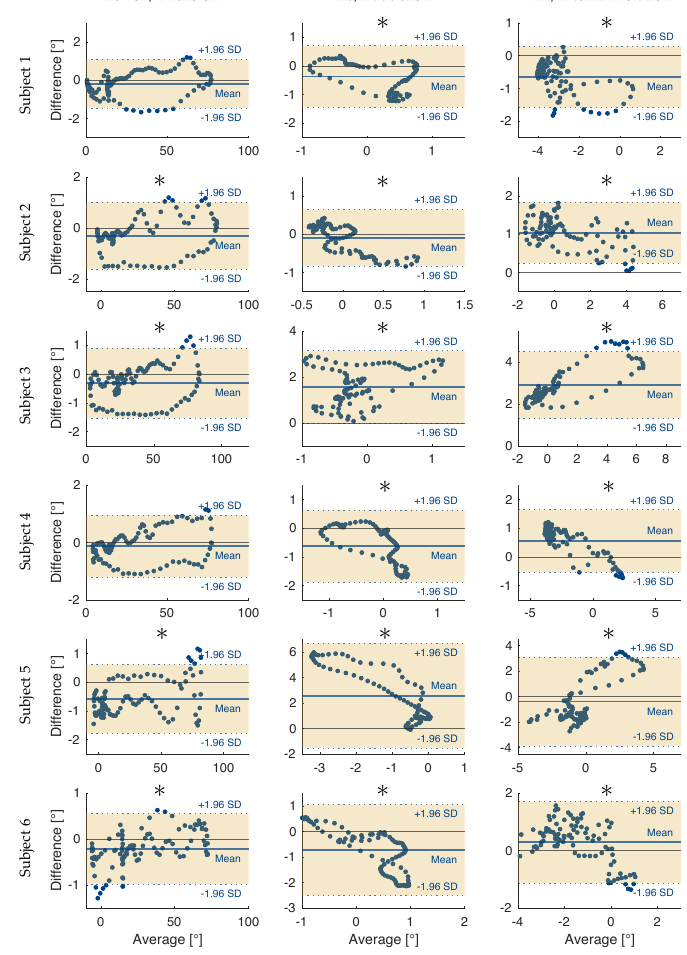
Figure A2. Bland-Altman plots for stair descent. Differences between simulator- and IMU-based estimates were plotted against the average of the two measures. Shaded areas denote two-tailed 95% confidence intervals while dotted blue lines represent limits of agreement and solid blue lines show the mean difference. Each row corresponds to a different subject; each column to a different plane of rotation. Inclusion of an asterisk indicates the assumption of normality was not